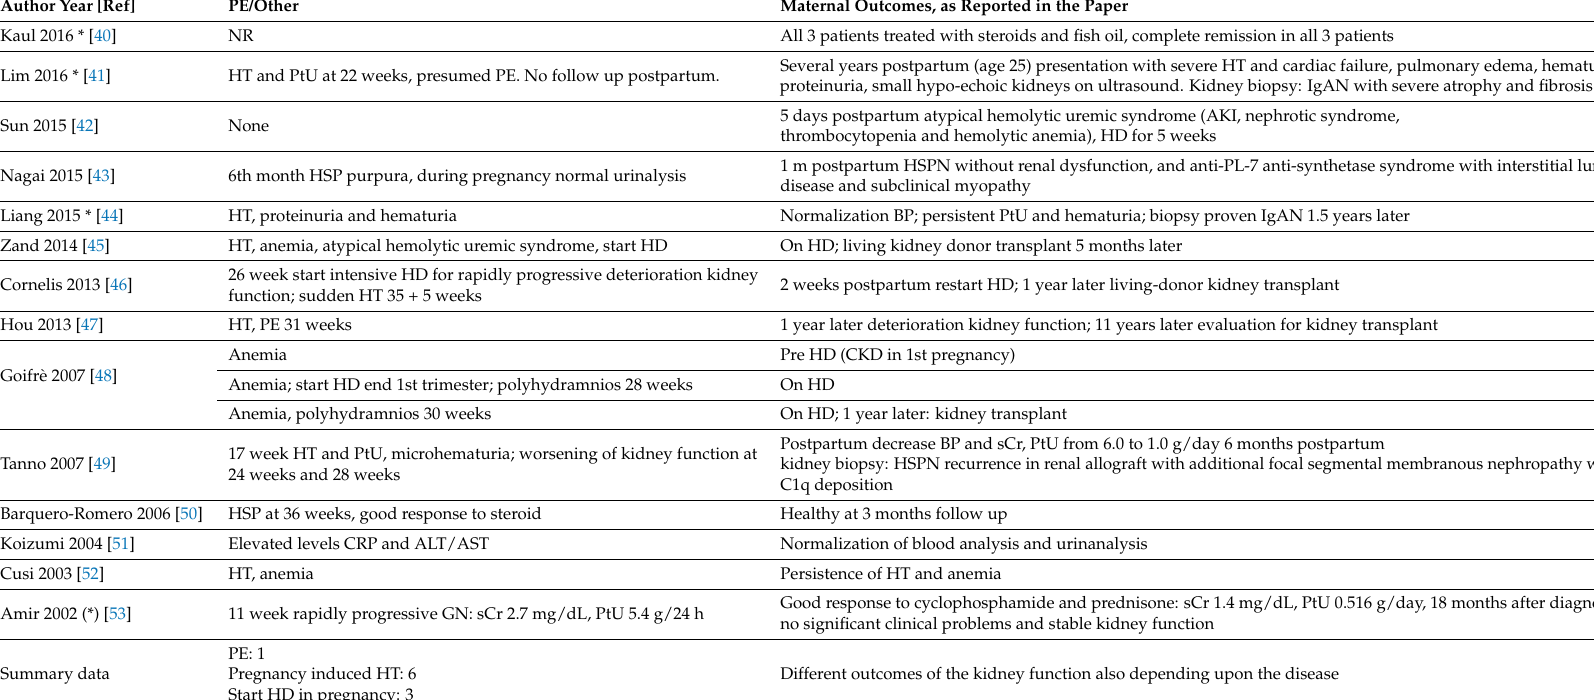
Table 7. IgA Nephropathy. Case reports: maternal